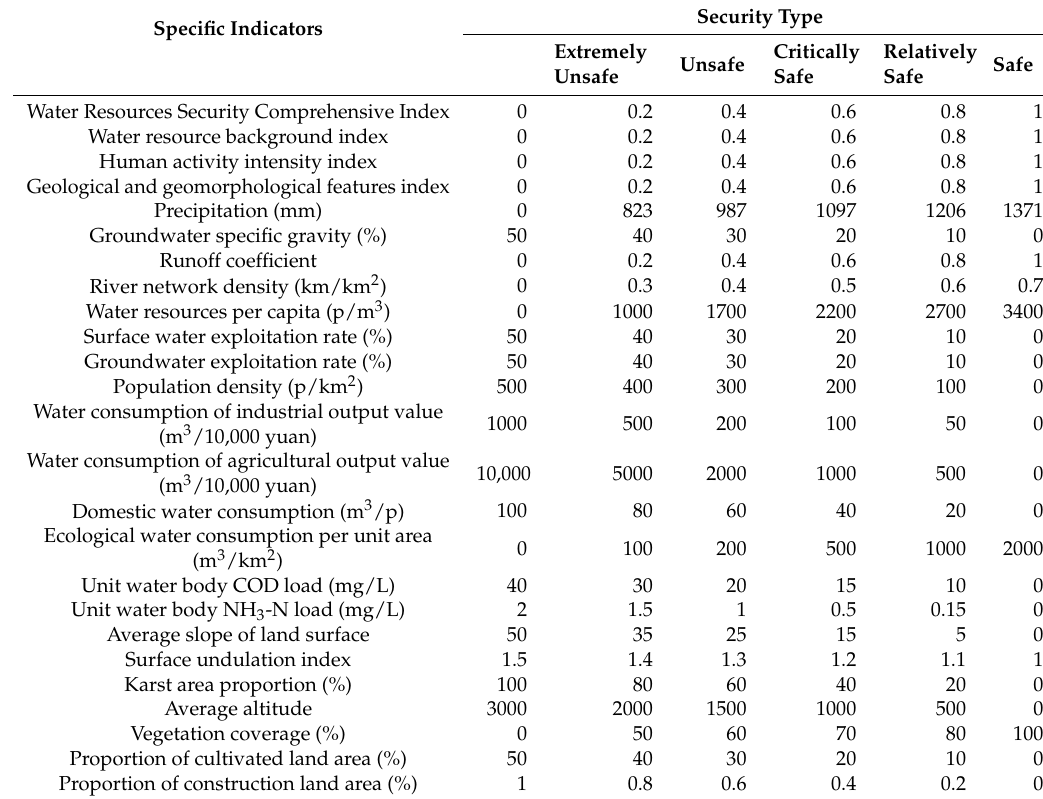
Table 2. Water resources security indicator grading standards and